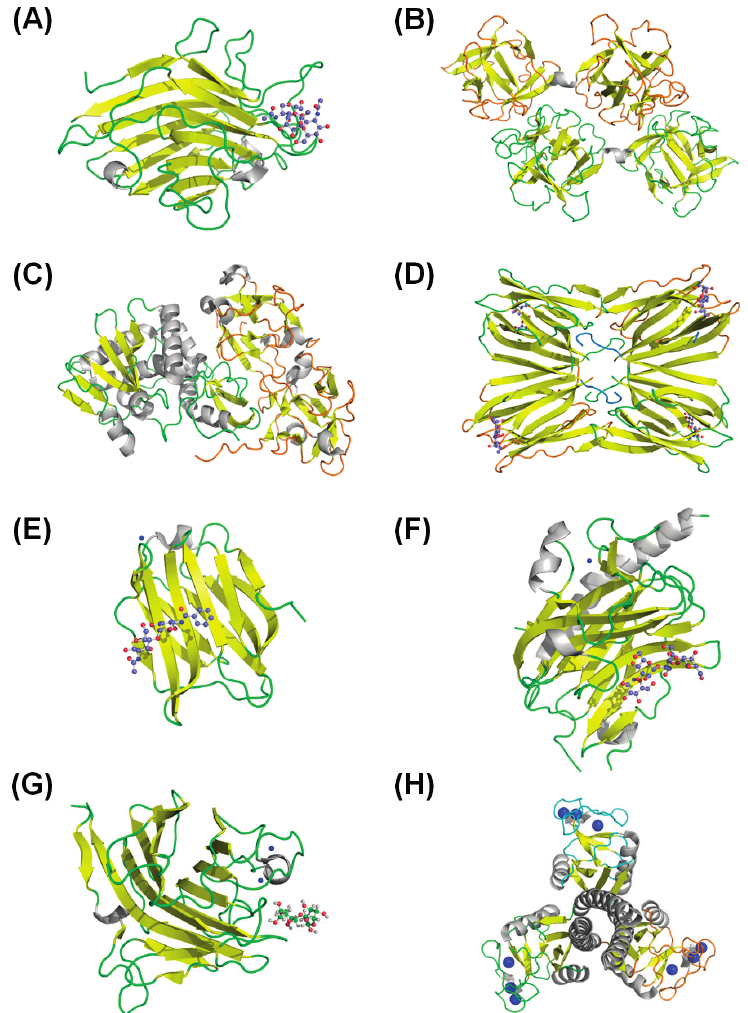
Figure 1. Lectin tridimensional structures in ( A ) arcein from Phaseolus vulgaris L. (pdb: 1ioa) [152]; ( B ) amaranthin from Amaranthus caudatus (pdb: 1jly) [138]; ( C ) ricin from Ricinus communis (pdb: 3rti) [140]; ( D ) jacalin from Artocarpus integer (pdb: 1m26) [142]; ( E ) galectin-3 from Homo sapiens (pdb: 2xg3) [145]; ( F ) calreticulin from Mus musculus (pdb: 3o0w) [147]; ( G ) Homo sapiens L-type (pdb: 4gkx) [150] and ( H ) Homo sapiens C-type (pdb: 1pwb) [151]. The colors yellow and white represented the secondary structures of β -sheet, α -helices in lectins, respectively. In addition, blue represents the Ca 2+ ion and carbohydrates are represented in ball and